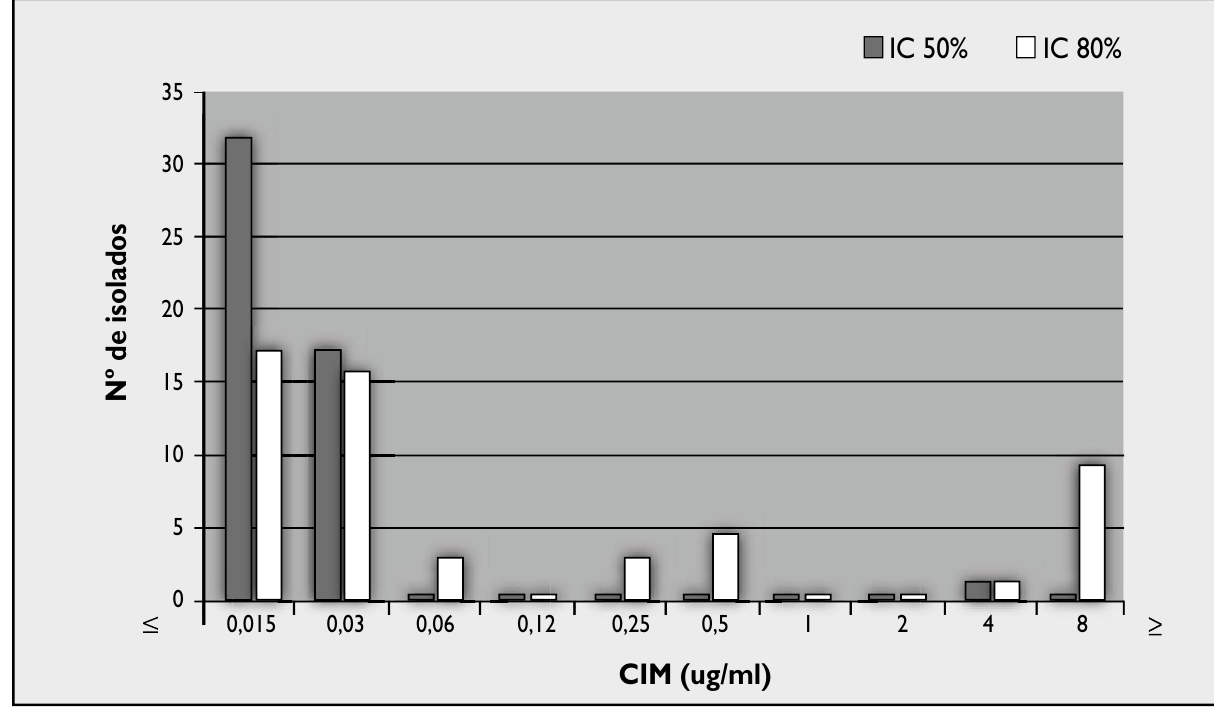
Figura 2 – Distribuição dos valores de CIM de itraconazol, calculados com índice de inibição de 50% e 80%, em isolados de Candida albicans do fl uido vaginal de 51 pacientes